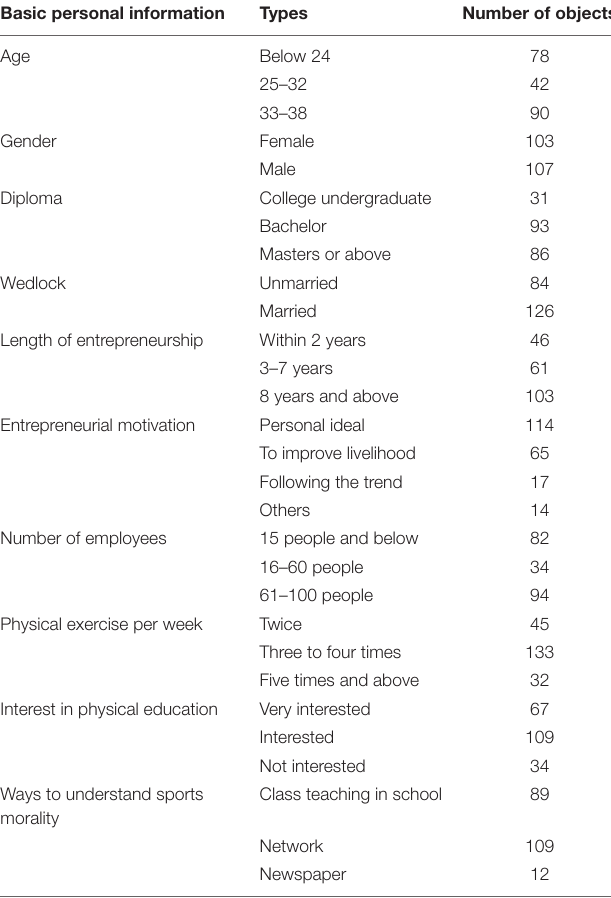
TABLE 5 | Descriptive analyses of QS data.